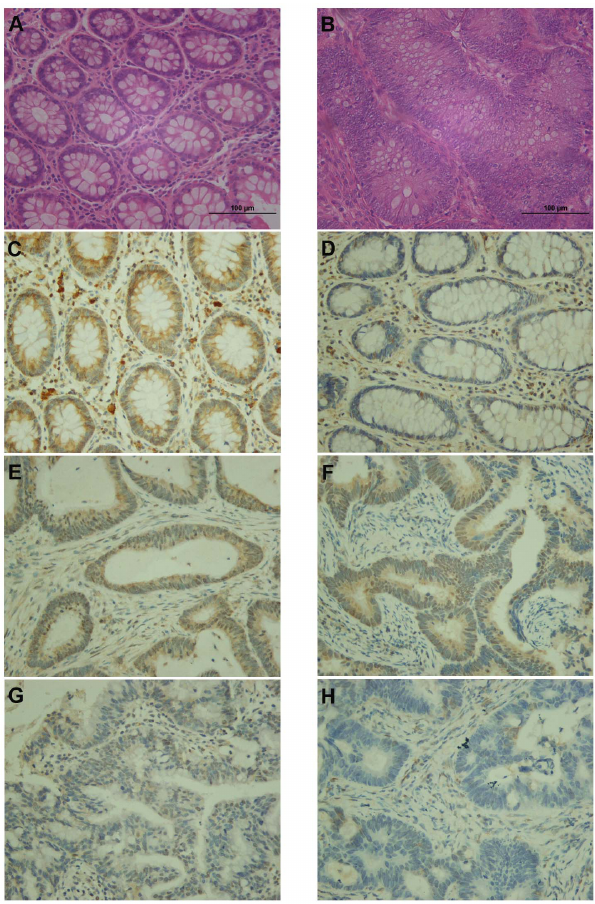
Figure 1. IHC staining of E2A in CRC tissues and normal mucosa. Representative images of IHC are shown as: (A) HE staining of normal mucosa; (B) HE staining of CRC tissue; (C) high E2A expression (brown color) presented as nuclear and cytoplasmic staining in normal mucosa; (D) low E2A expression in normal mucosa; (E–H) stage I (E) to stage II (F), III (G), and IV (H) CRC tissues with different E2A staining